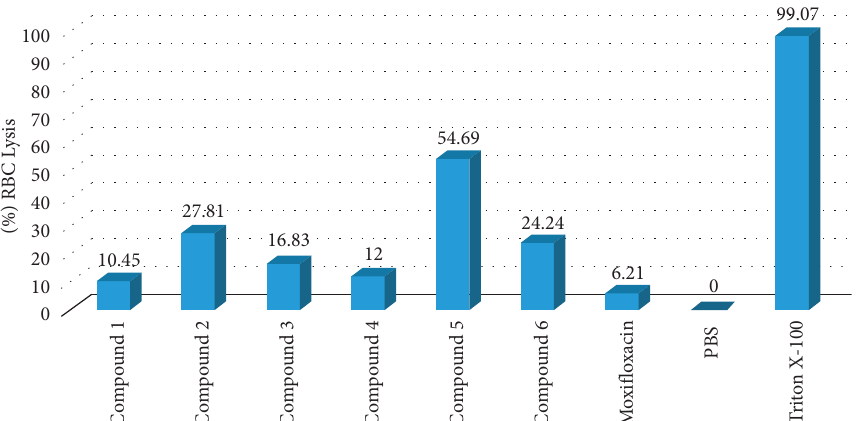
Figure 7: Te cytotoxic activity of synthesised metal complexes against moxifoxacin in the presence of positive control (triton X-100) and negative control